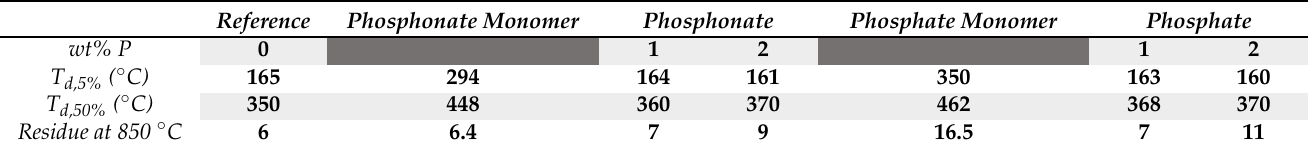
Table 3. Results of TGA analyses of reference EC alkyd resin and PO x CR diluent EC alkyd resins.